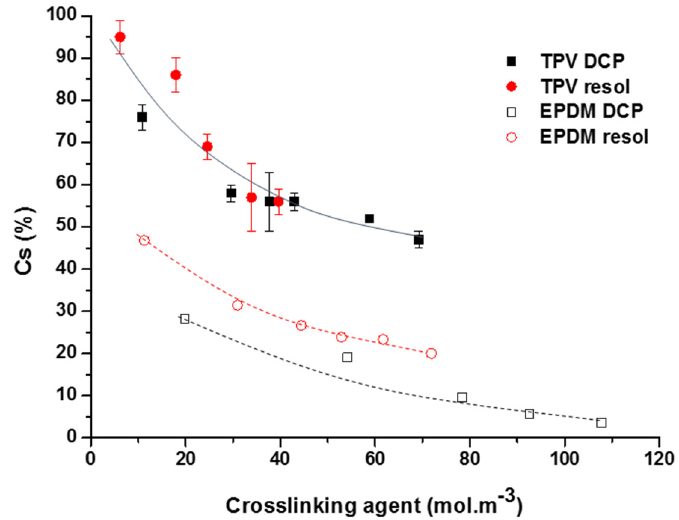
Figure 5. Variation of the compression set versus the molar concentration of the crosslinking agent for TPV with 75 phr of PP. Comparison between the TPV (full symbols) and the neat EPDM systems (open symbols from our previous work [18]).